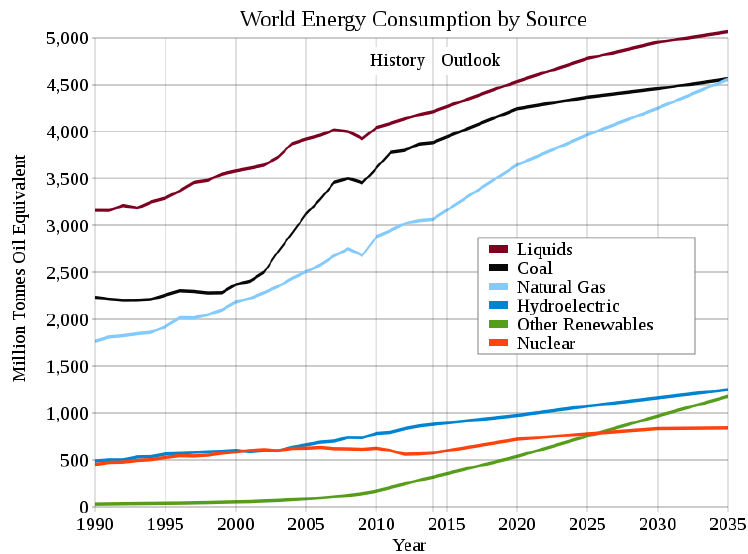
Figure 5. World energy consumption outlook 2015 (https://commons.wikimedia.org/wiki/File:World_Energy_Consumption_Outlook_2015.svg, accessed on 8 July 2021).